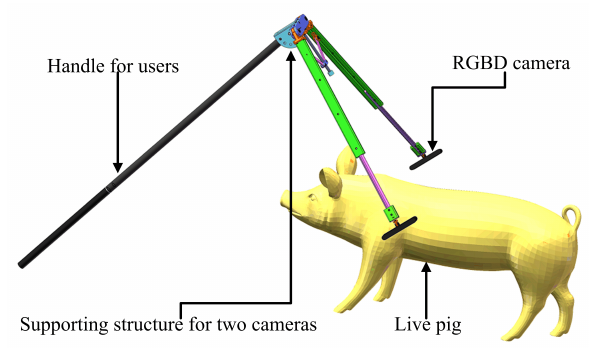
Figure 1. Capturing setup for scanning live